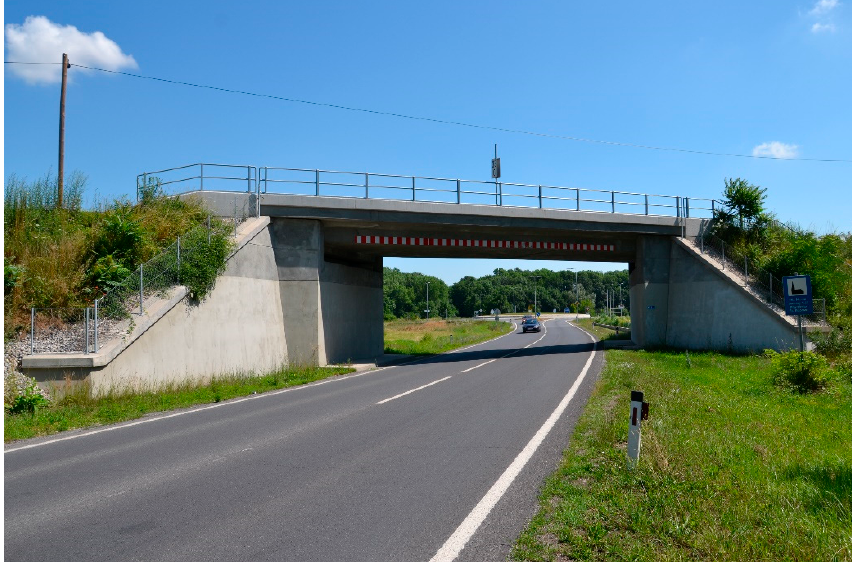
Table 10. Condition rating system used by the ÖBB, with assigned condition, restriction, and action for each class [5].